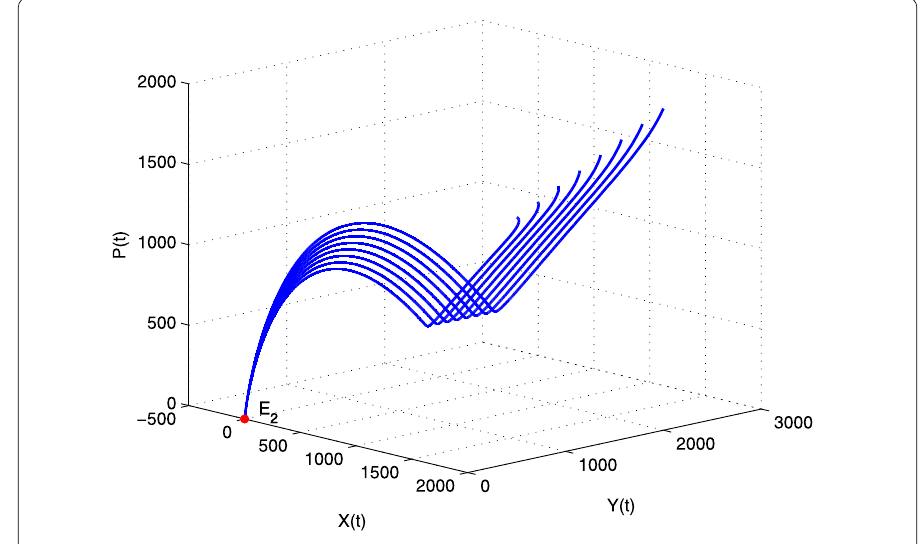
Figure 4 The boundary equilibrium E 2 is locally asymptotically stable with the parameters a 1 = 1, a